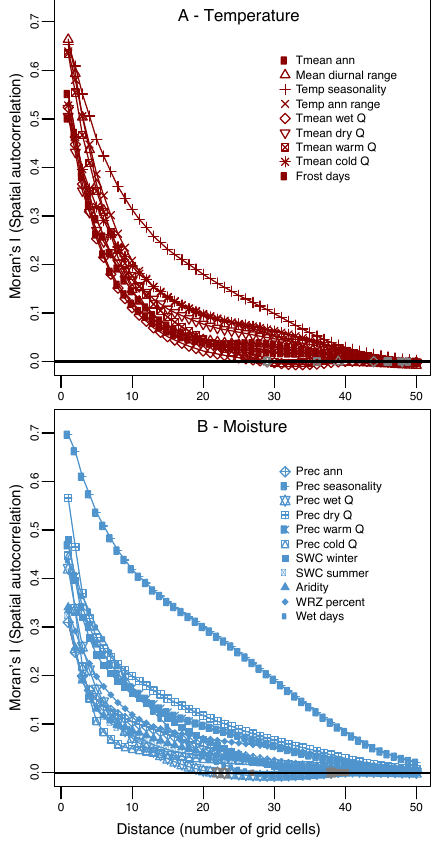
Figure 7. Moran’s I autocorrelogram. The spatial autocorrelation is plotted for each variable against different distances (measured in grid cells). Each grid cell is about 28km large/high. Grey sym- bols represent non-significant values; α = 0 . 001 after the Bonfer- roni correction. Only 17 out of 1000 tests are non-significant.